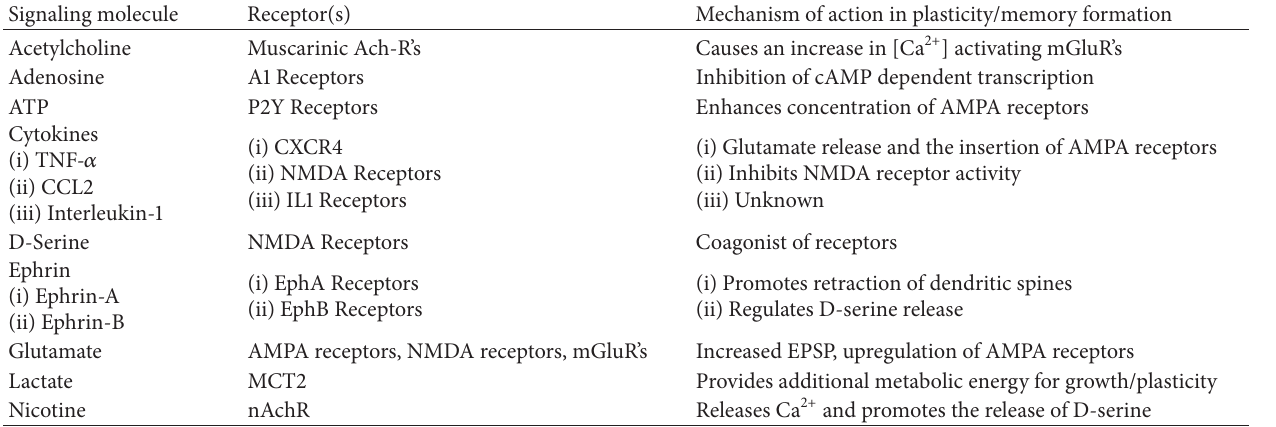
Table 1: Summary of receptors/signaling molecules and related